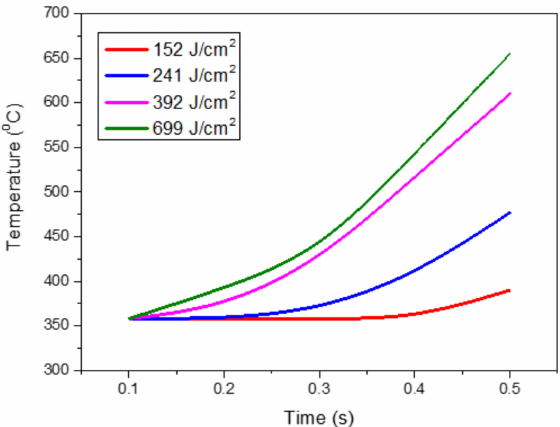
Figure 5. Under the condition of multi-pulse laser, the temperature rise time of laser damaged CFRP (braided) surface changes with the pulse